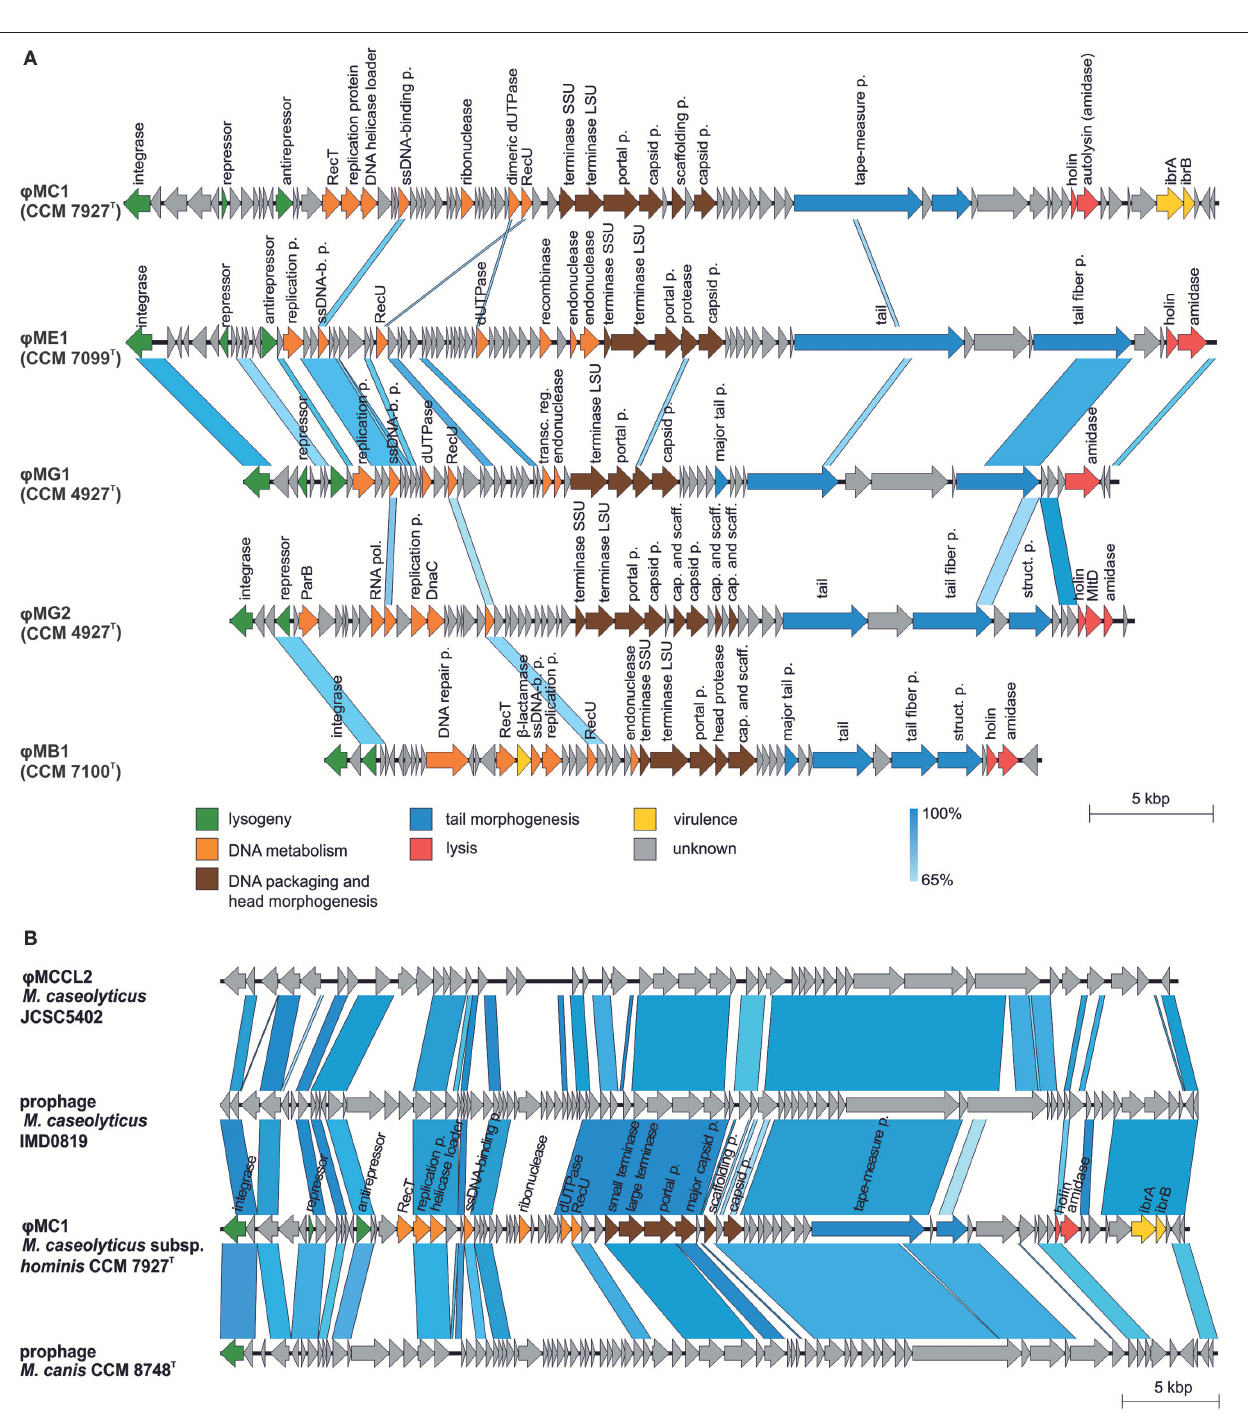
FIGURE 7 | Comparative genomics of macrococcal bacteriophages. (A) Mutual comparison of highly divergent prophage genomes from human macrococci: ϕ MC1 (CCM 7927 T ), ϕ ME1 (CCM 7099 T ), ϕ MG1 (CCM 4927 T ), ϕ MG2 (CCM 4927 T ), and ϕ MB1 (CCM 7100 T ). (B) Genome comparison of converting phage ϕ MC1 from Macrococcus caseolyticus subsp. hominis subsp. nov. CCM 7927 T with M. caseolyticus JCSC5402 phage ϕ MCCL2, phage from M. caseolyticus IMD081D and phage from M. canis CCM 8748 T . Genomes were aligned using the blastn algorithm and similar regions with more than 65% identity are indicated. The positions and orientations of the coding regions are represented by arrows. Genome modules are color-coded according to the legend.